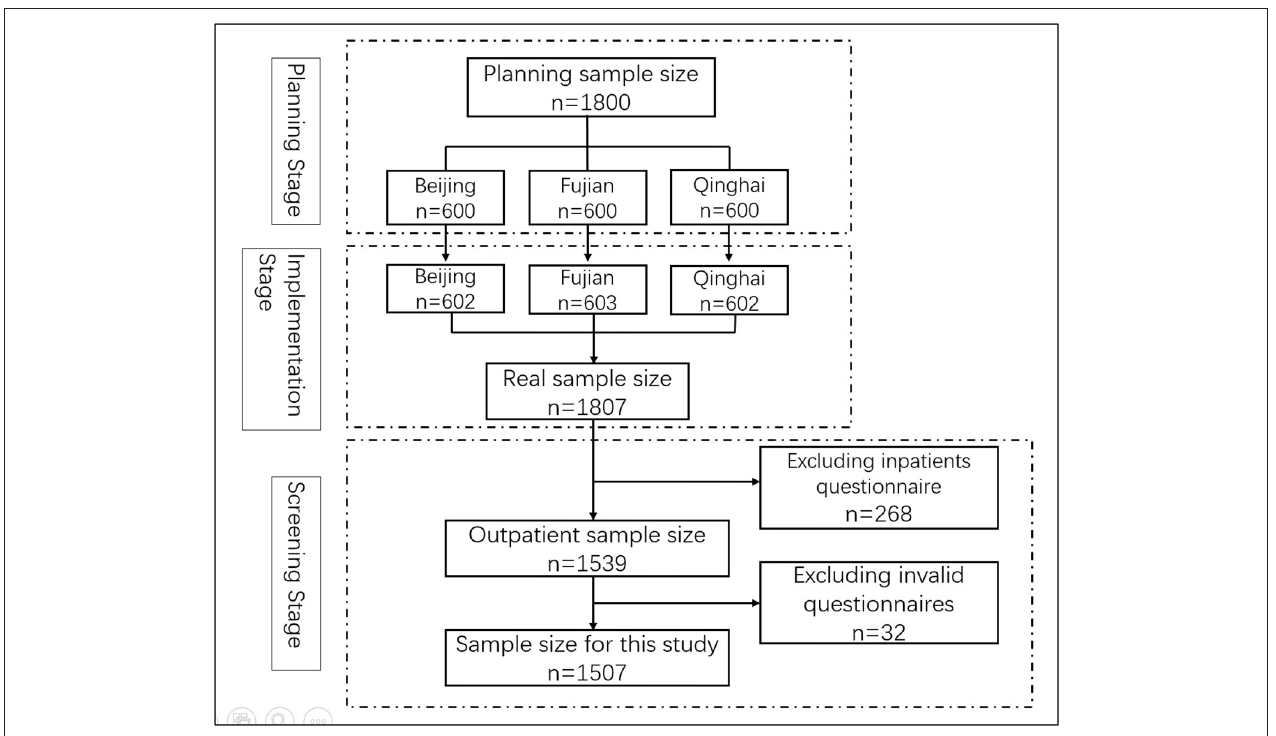
FIGURE 1 | Flow chart of the selection of